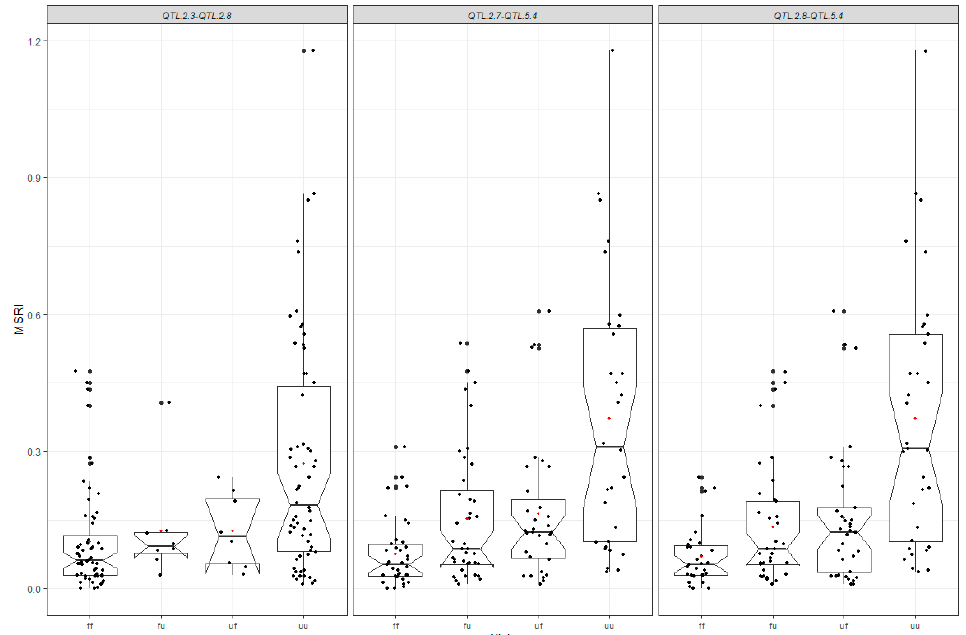
Figure 3. Box plots of marsh spot resistance index (MSRI) in terms of the combinations of favorable alleles of three quantitative trait locus (QTL) pairs identified using the ICIM-EPI model. In each box plot, the black dots represent data points and the red dot represents the mean of the data points. ff: both QTL 1 and QTL 2 were favorable alleles. uf: QTL 1 was an unfavorable allele while QTL 2 was a favorable allele; fu: QTL 1 was a favorable allele but QTL 2 was an unfavorable allele; uu: both QTL 1 and QTL 2 were unfavorable alleles.